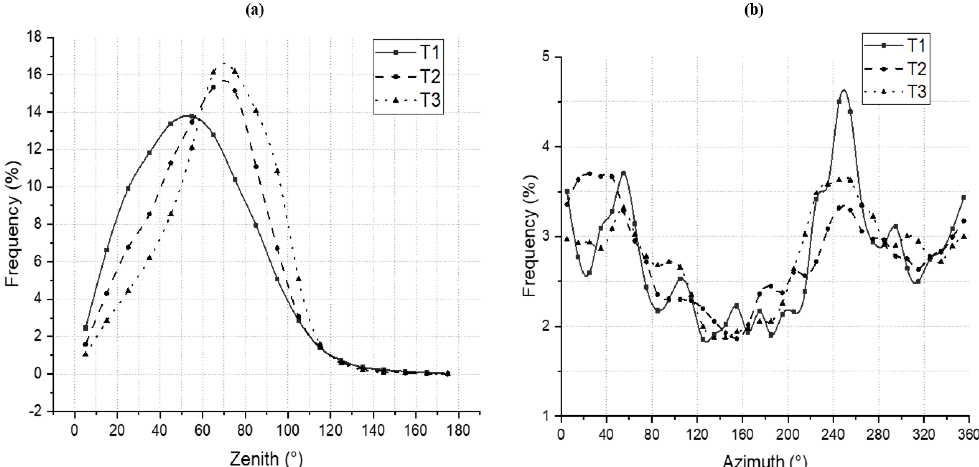
Figure 4. Frequencies of leaf zenith ( a ) and azimuth ( b ) angles for the reference structures. (T1: first stage, T2: second stage, and T3: third stage, this annotation will be used henceforth).